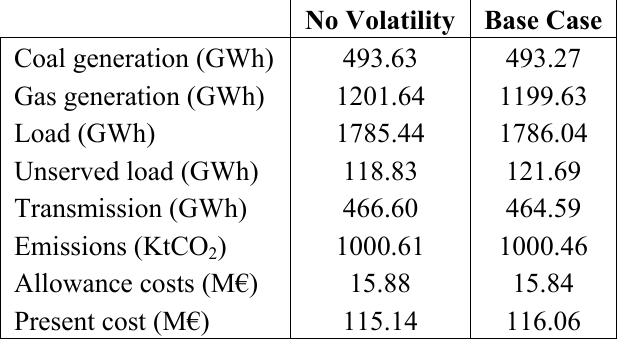
Table 4. Average generation, load, transmission, and costs ( 1 L ): Deterministic case vs. base